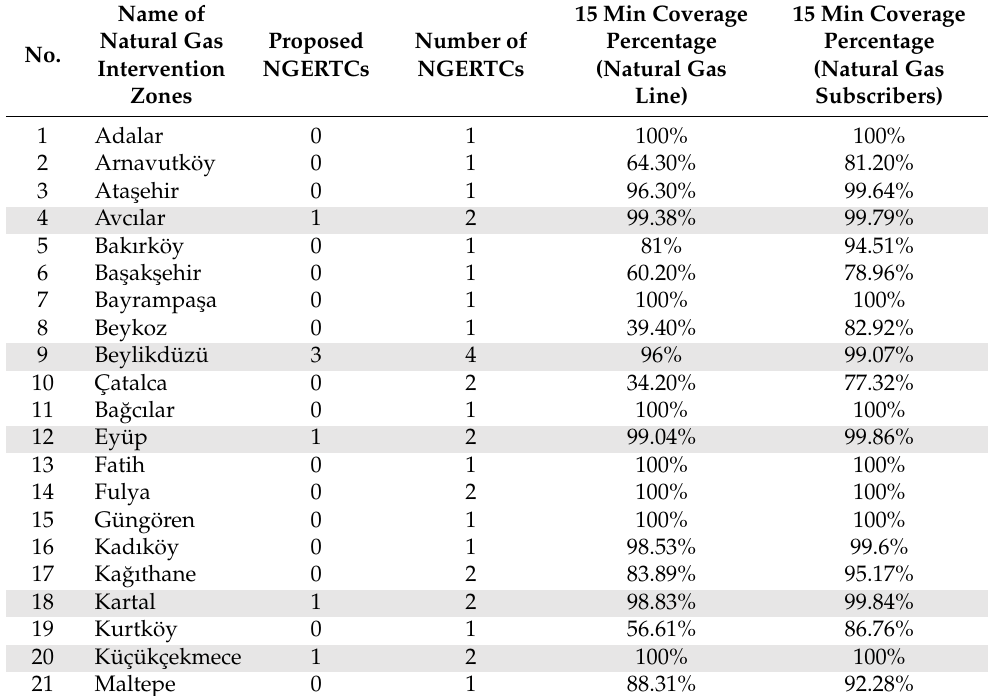
Table 8. Coverage percentage and number of existing and proposed NGERTCs by intervention zones.